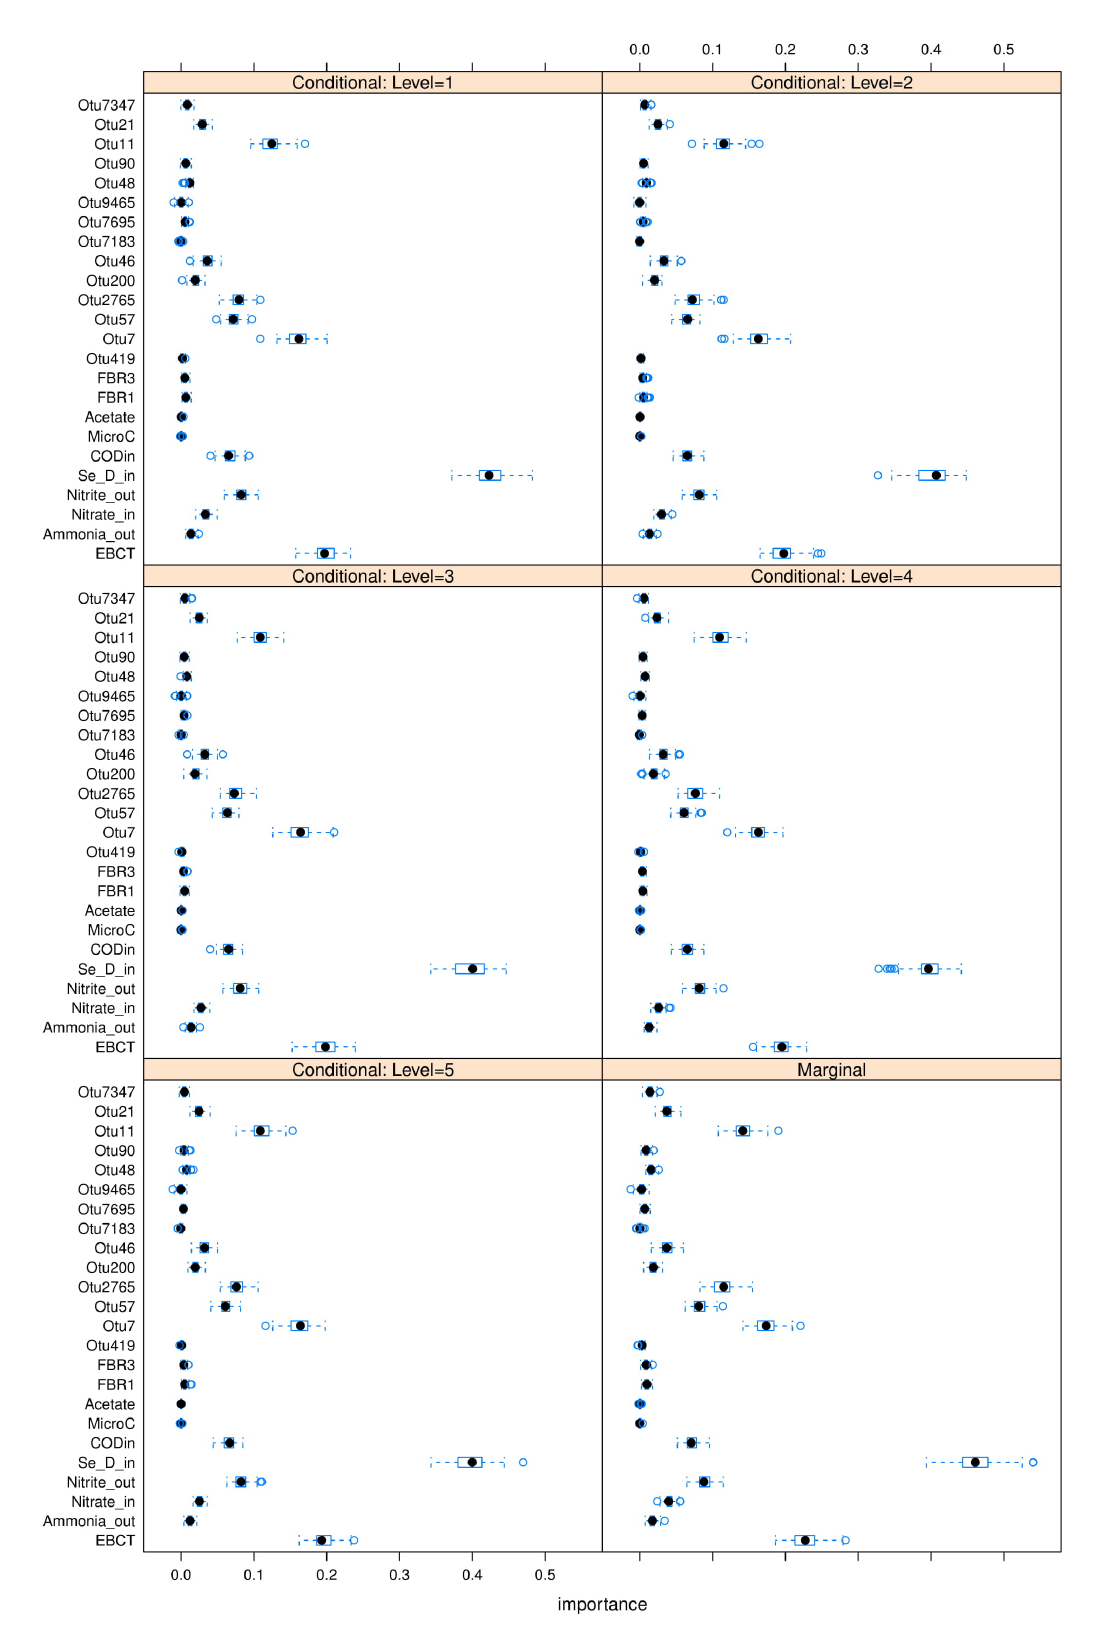
Figure A24. Conditional feature importances for GMM